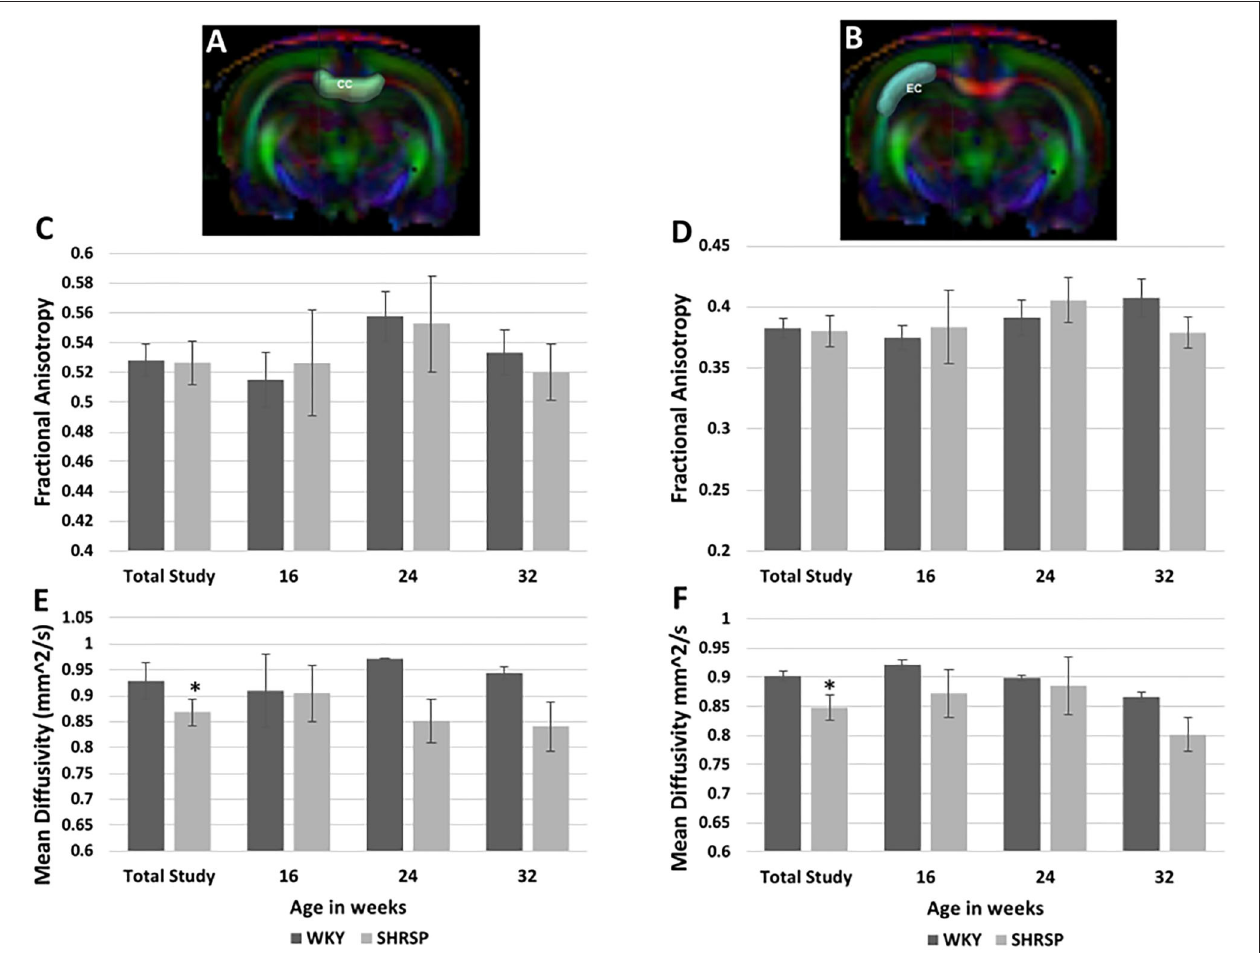
FIGURE 5 | Diffusion Tensor Imaging (DTI) analyses of the corpus callosum and external capsule in SHRSP and WKY show higher mean diffusivity (MD) values in WKY compared to SHRSP in both structures (E,F) . This difference was only statistically significant in the total study animals. The fractional anisotropy (FA) was not statistically different between WKY and SHRSP in both structures (C,D) . Segmentation of corpus callosum is shown on one slice of the color map in (A) (CC) and the external capsule segmentation is shown at the same level in (B) (EC). CC, corpus callosum; EC, external capsule; mm 2 /s: square milli meter per second ; * statistically significant difference of P < 0.05. Data represent the mean and standard error of the